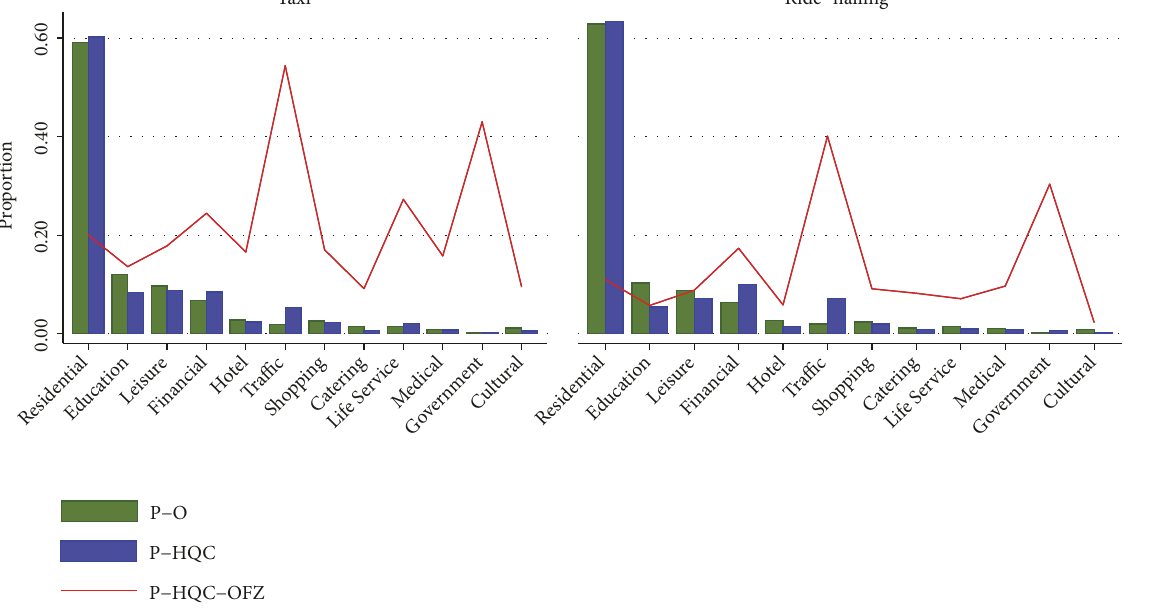
Figure 8: The distributions of orders and HQC in different functional zones. Note: P-HQC-OFZ refers to the proportion of HQC in the total orders of the corresponding functional